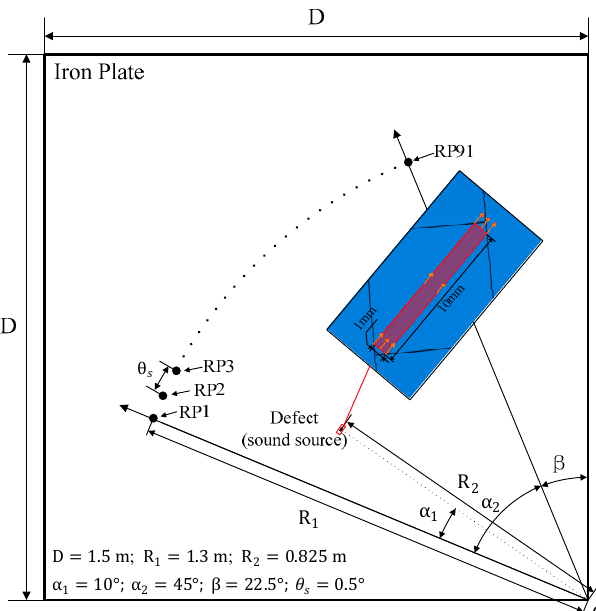
Figure 7. The diagram of the numerical model.